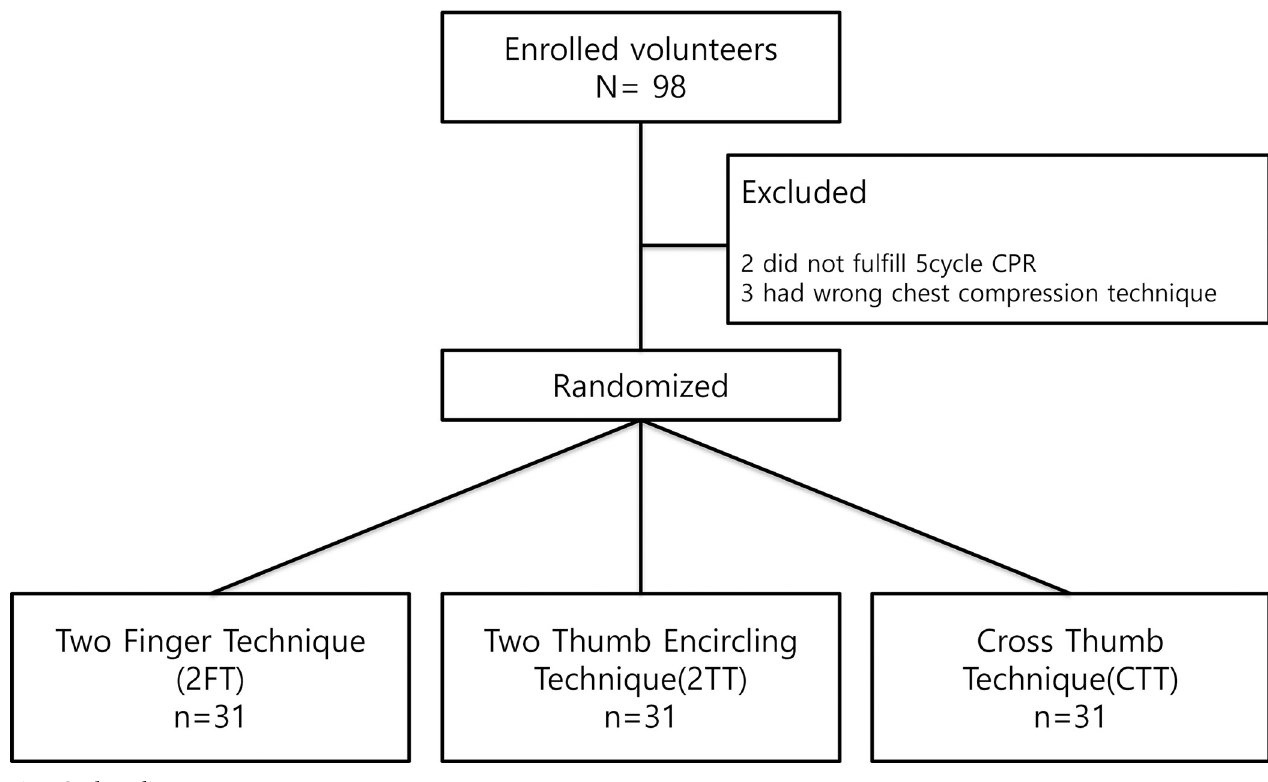
Fig 3. Study outlines.